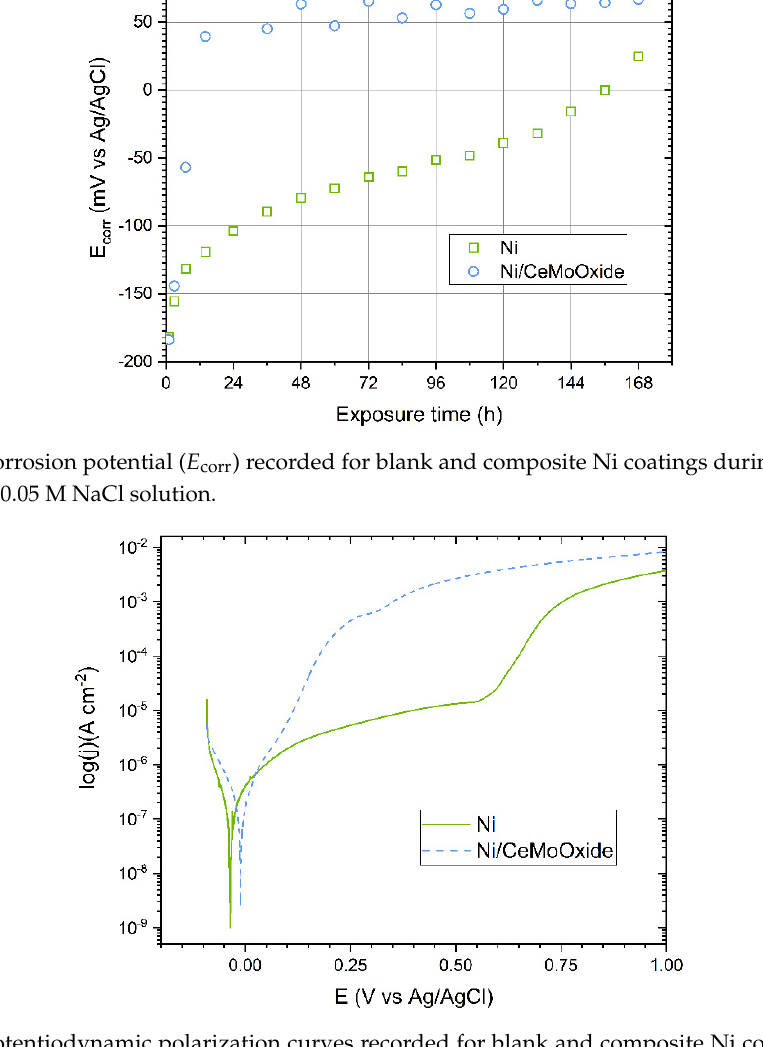
Figure 6. Potentiodynamic polarization curves recorded for blank and composite Ni coatings after 168-hour exposure to 0.05 M NaCl solution.